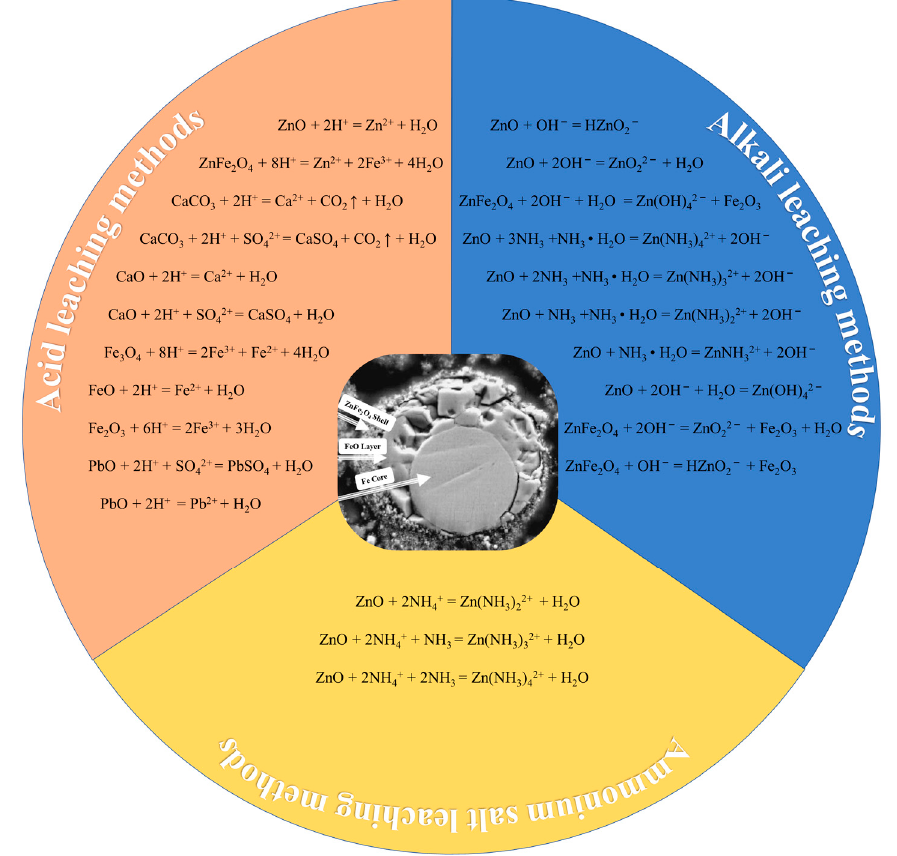
Figure 4. Main chemical reactions in hydrometallurgy process [22–25] (the internal picture is a SEM image of an SMD particle [26]).